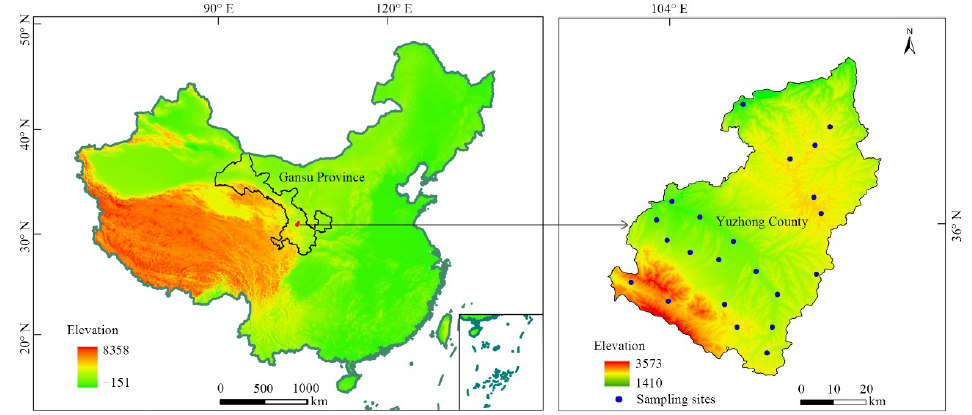
Figure 2. Location and survey sites in the study area.